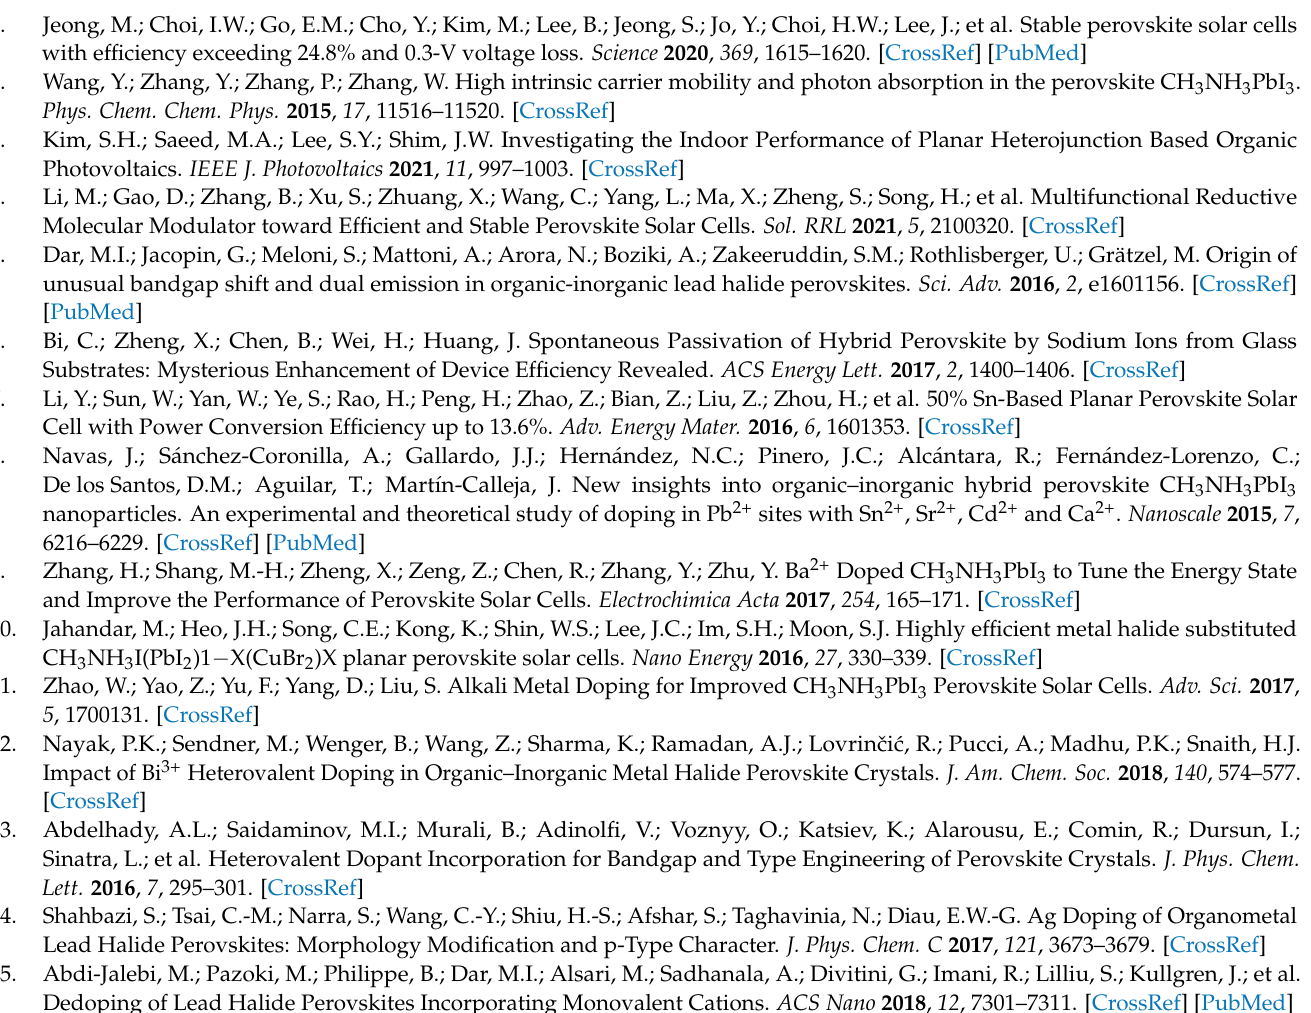
Figure S5. Steady power conversion efficiency curve of the 1.0% Ag-doped perovskite solar cell; Table S1: Table S1. Photovoltaic performances summary of the perovskite